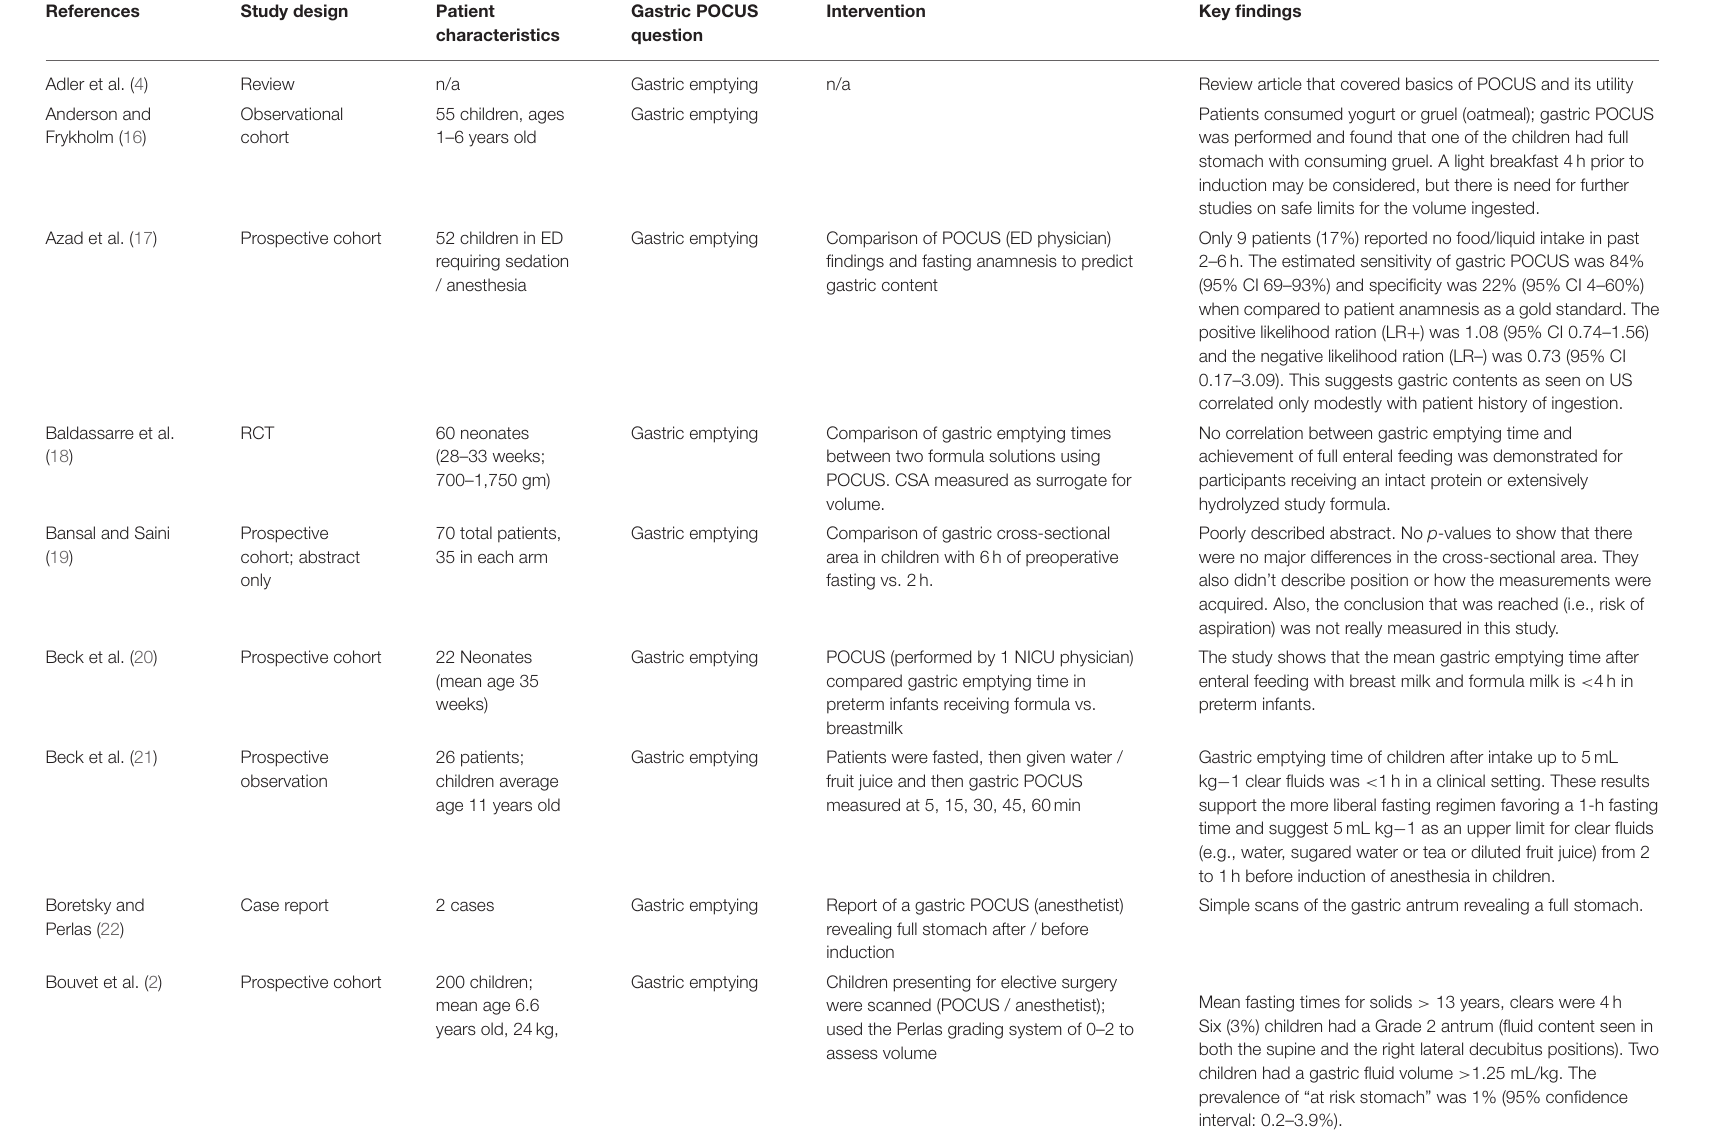
TABLE 1 | Study characteristics and findings: gastric emptying and gastric content